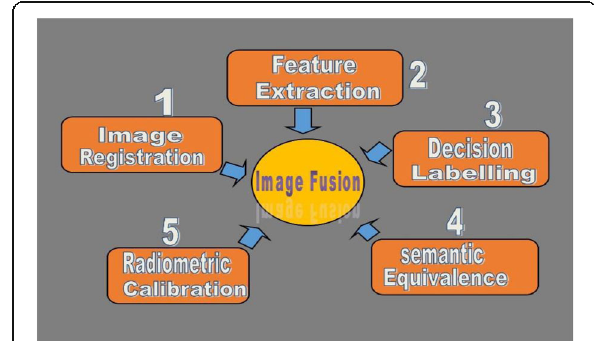
Fig. 3 Steps in image fusion